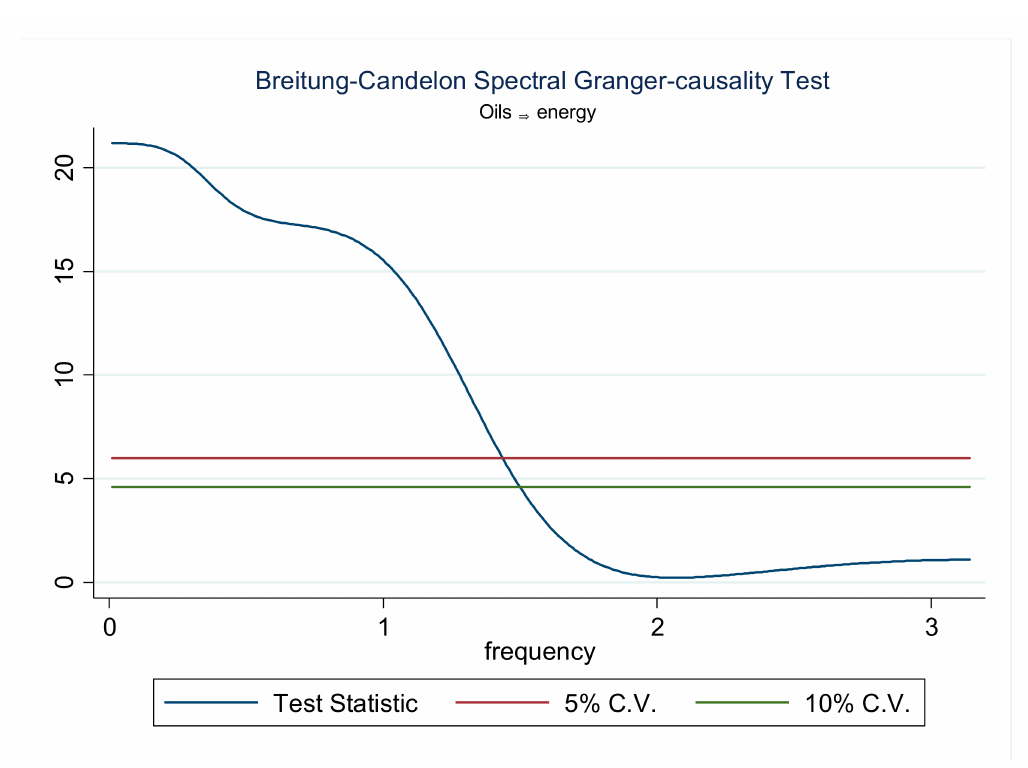
Figure 4. Spectral BC causality from oils to